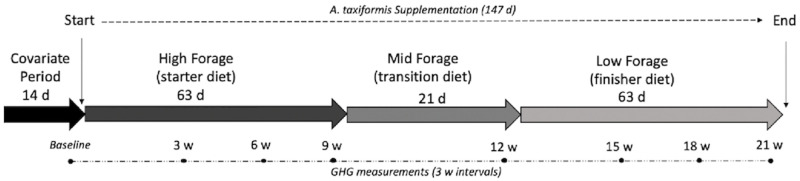
Experimental timeline including covariate period, Asparagopsis taxiformis implementation, dietary regime, and greenhouse gas measurement intervals.